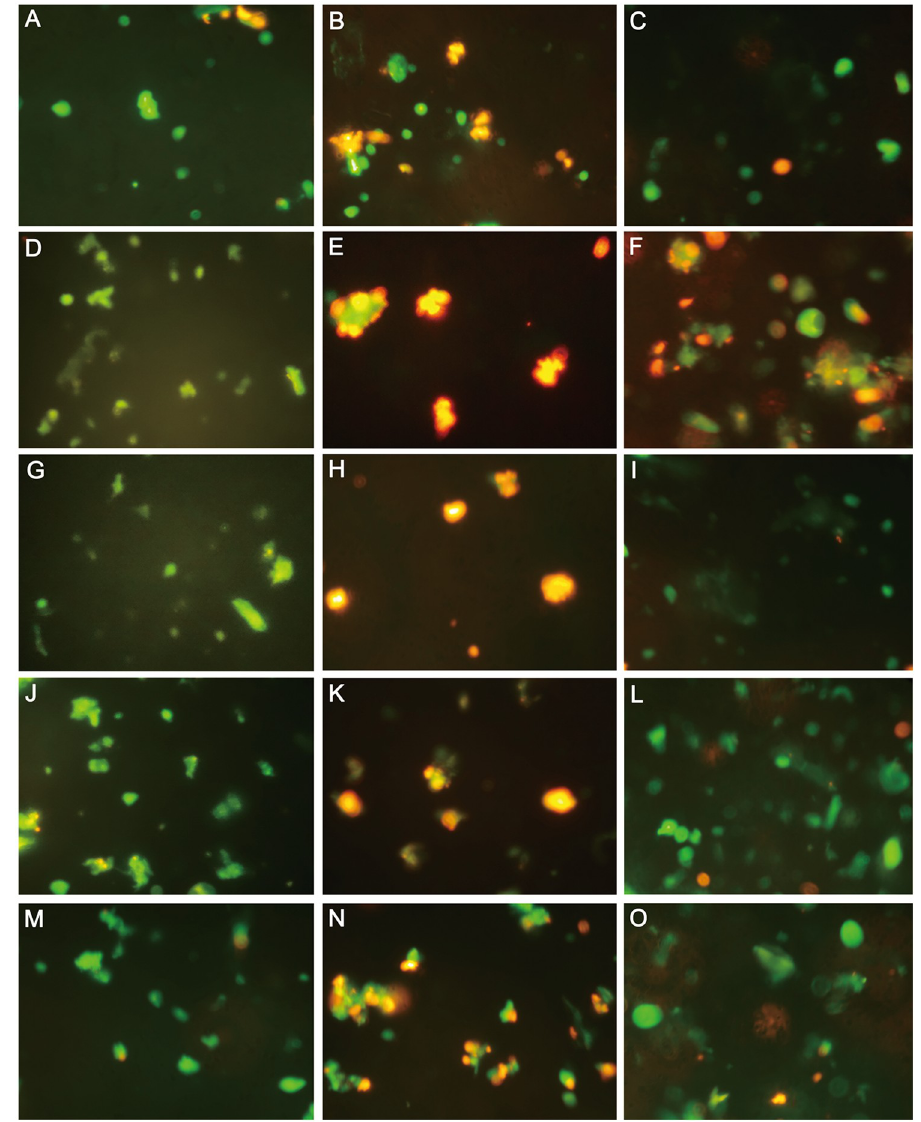
Fig 11. JC-1 staining of protoplasts from mung bean hypocotyls in different preimbibition and dehydration states. A, D, G, J and M show the positive control of preimbibed protoplasts 3, 6, 18 and 24 h after the CCCP treatment, respectively. B, E, H, K and N show the staining of preimbibed protoplasts at 0, 3, 6, 18 and 24 h, respectively. C, F, I, L and O show the preimbibed protoplasts with 0, 3, 6, 18 and 24 h after 24 h of dehydration,